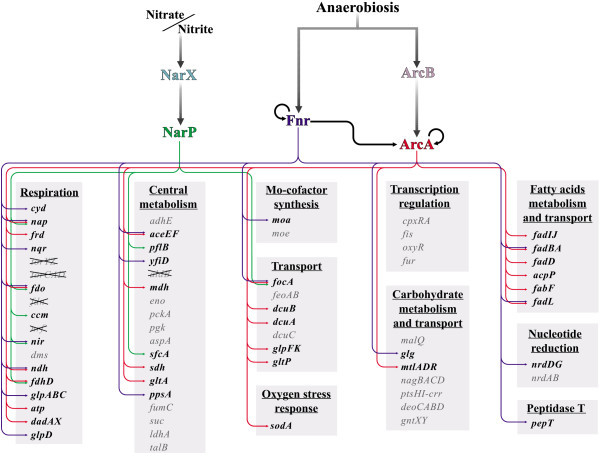
Regulatory interactions in Yersinia spp. Regulatory cascades are shown by thick black arrows. Predicted transcriptional regulation is shown by thin arrows, blue for Fnr, red for ArcA, and green for NarP.